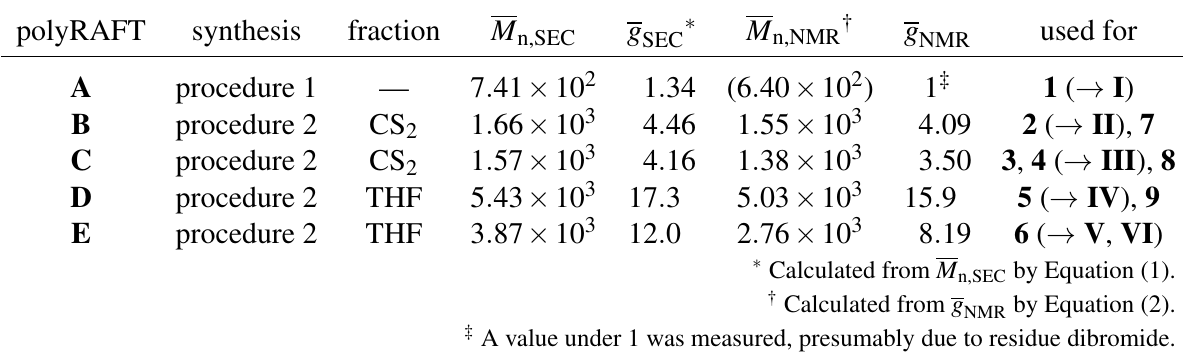
Table 1. Overview of polyfunctional RAFT agents that were employed for further polymerizations in this study with synthesis method, average numbers of TTC groups g and number average molar masses M , determined via SEC and NMR. The last column indicates n the polymerization in which they were employed (see Tables 2 and 3) and, in parentheses, the copolymerization for which the respective polymerization products were